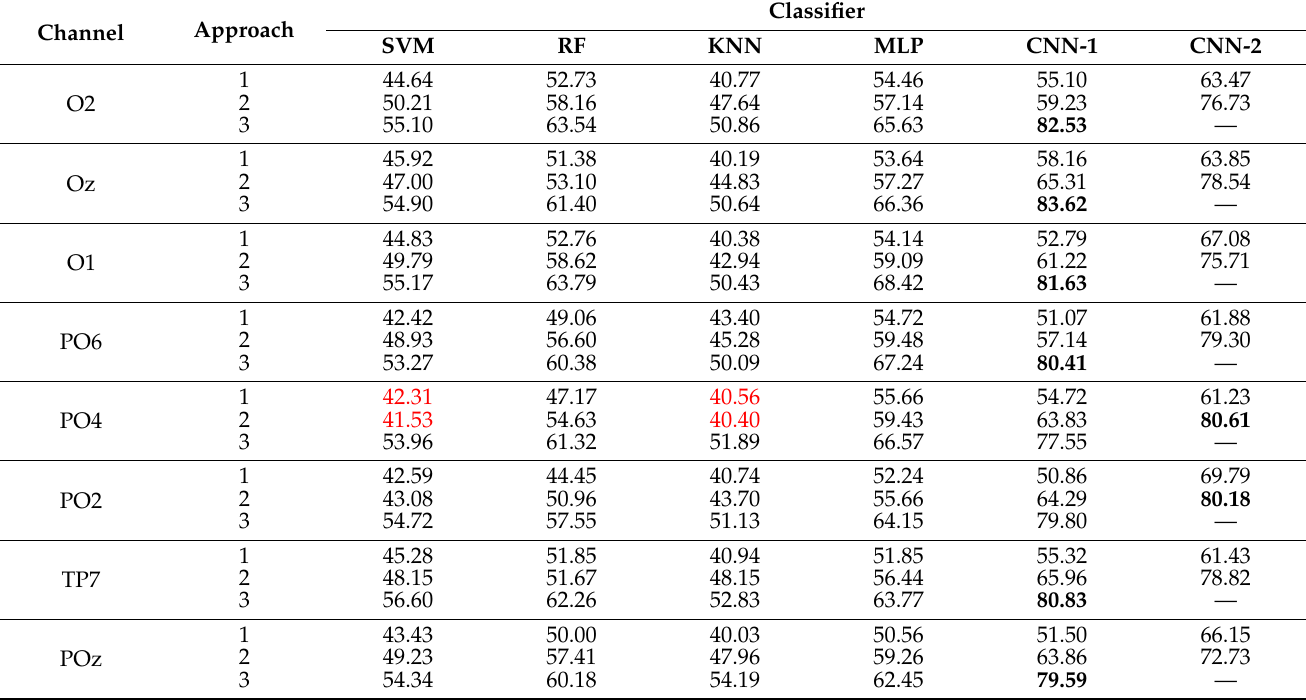
Table A6. Single trial classification accuracies of the 1-ERPs of Subject b 3 . Inconsistent results are highlighted in red. The best result for each channel is highlighted in bold